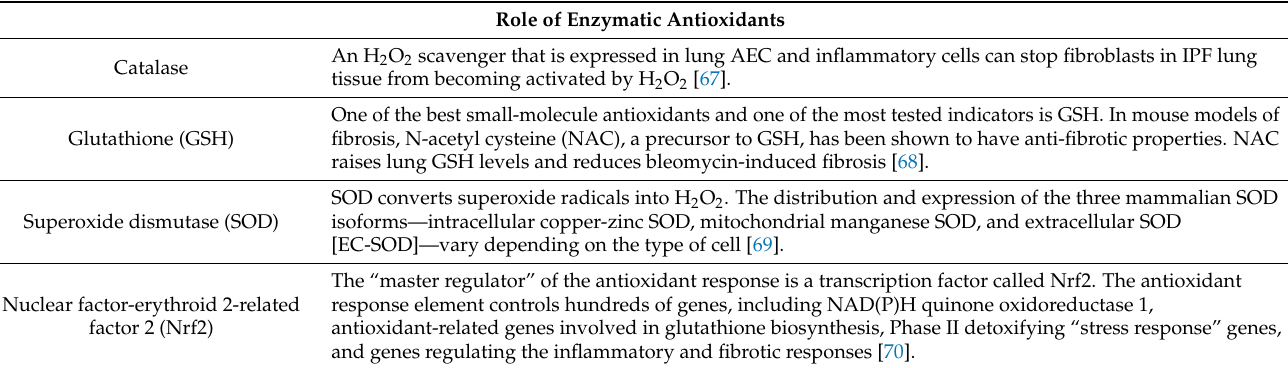
Table 1. Antioxidant defense